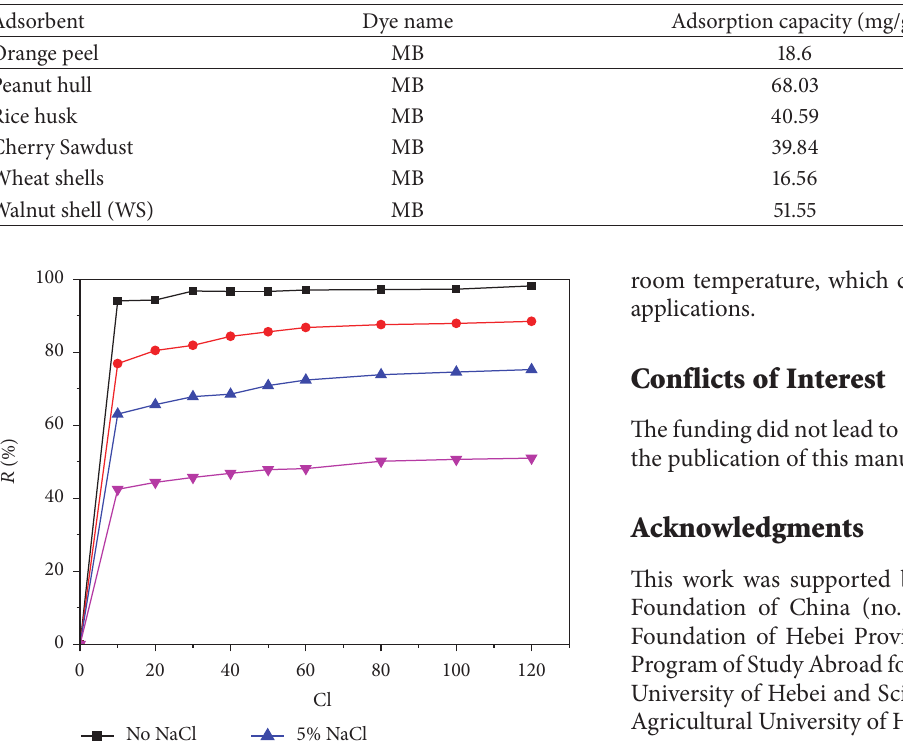
Table 6: Comparison of MB adsorption capacity with some environmental-friendly adsorbents.